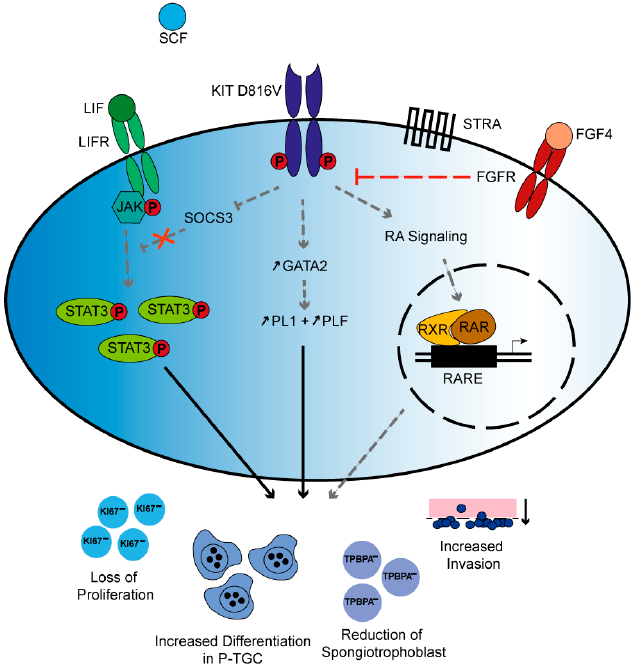
Figure 6. Proposed mechanism of KIT D816V signaling in TSC: Schematic summary depicting possible signaling mechanisms that lead to KIT D816V placental phenotype observed in this study. Independent of SCF binding, the KIT D816V receptor is active. KIT inhibits SOCS3, thereby interrupting the negative feedback loop of Leukemia Inhibitory Factor (LIF) signaling resulting in accumulation of P-STAT3. Further, KIT signaling induces the expression of GATA2, which then transactivates PL1 and PLF. Independent of retinoic acid (RA) presence, KIT impinges on RA-controlled gene expression. Taken together, chronic KIT D816V signaling results in severely diminished placental proliferation and reduction of spongiotrophoblast cells but increase in differentiation towards P-TGC and elevated invasion. In the presence of FGF4, Fibroblast Growth Factor Receptor (FGFR) signaling can override KIT-mediated signals. The black arrows indicate relations found in this study, whereas the gray and dashed arrows present hypothetical interactions, some of which have only been demonstrated in other cell types and T bars indicate repression.